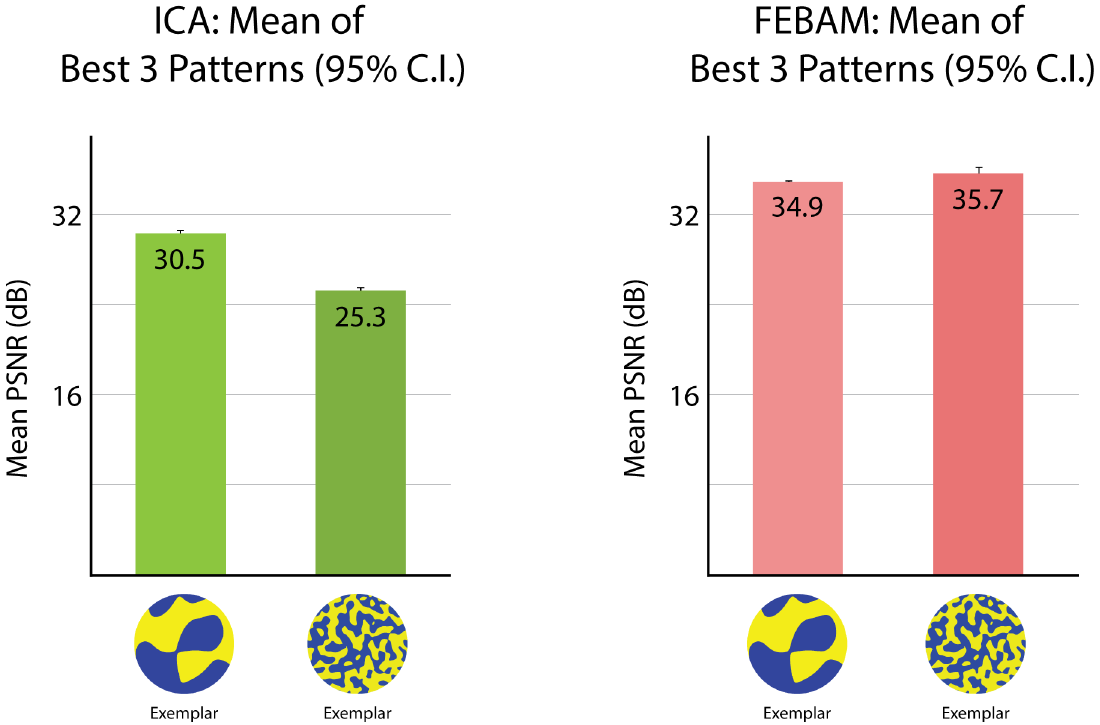
Fig 7. PSNR reconstruction values for high and low spatial frequency asymmetric patterns. Results are based on the three patterns reconstructed in best quality (i.e., left-most patterns from Figs 4 and 5), each pattern simulation performed 50 times. Error bars show 95% confidence interval. The figure shows test patterns in their original form, as used in the behavioural